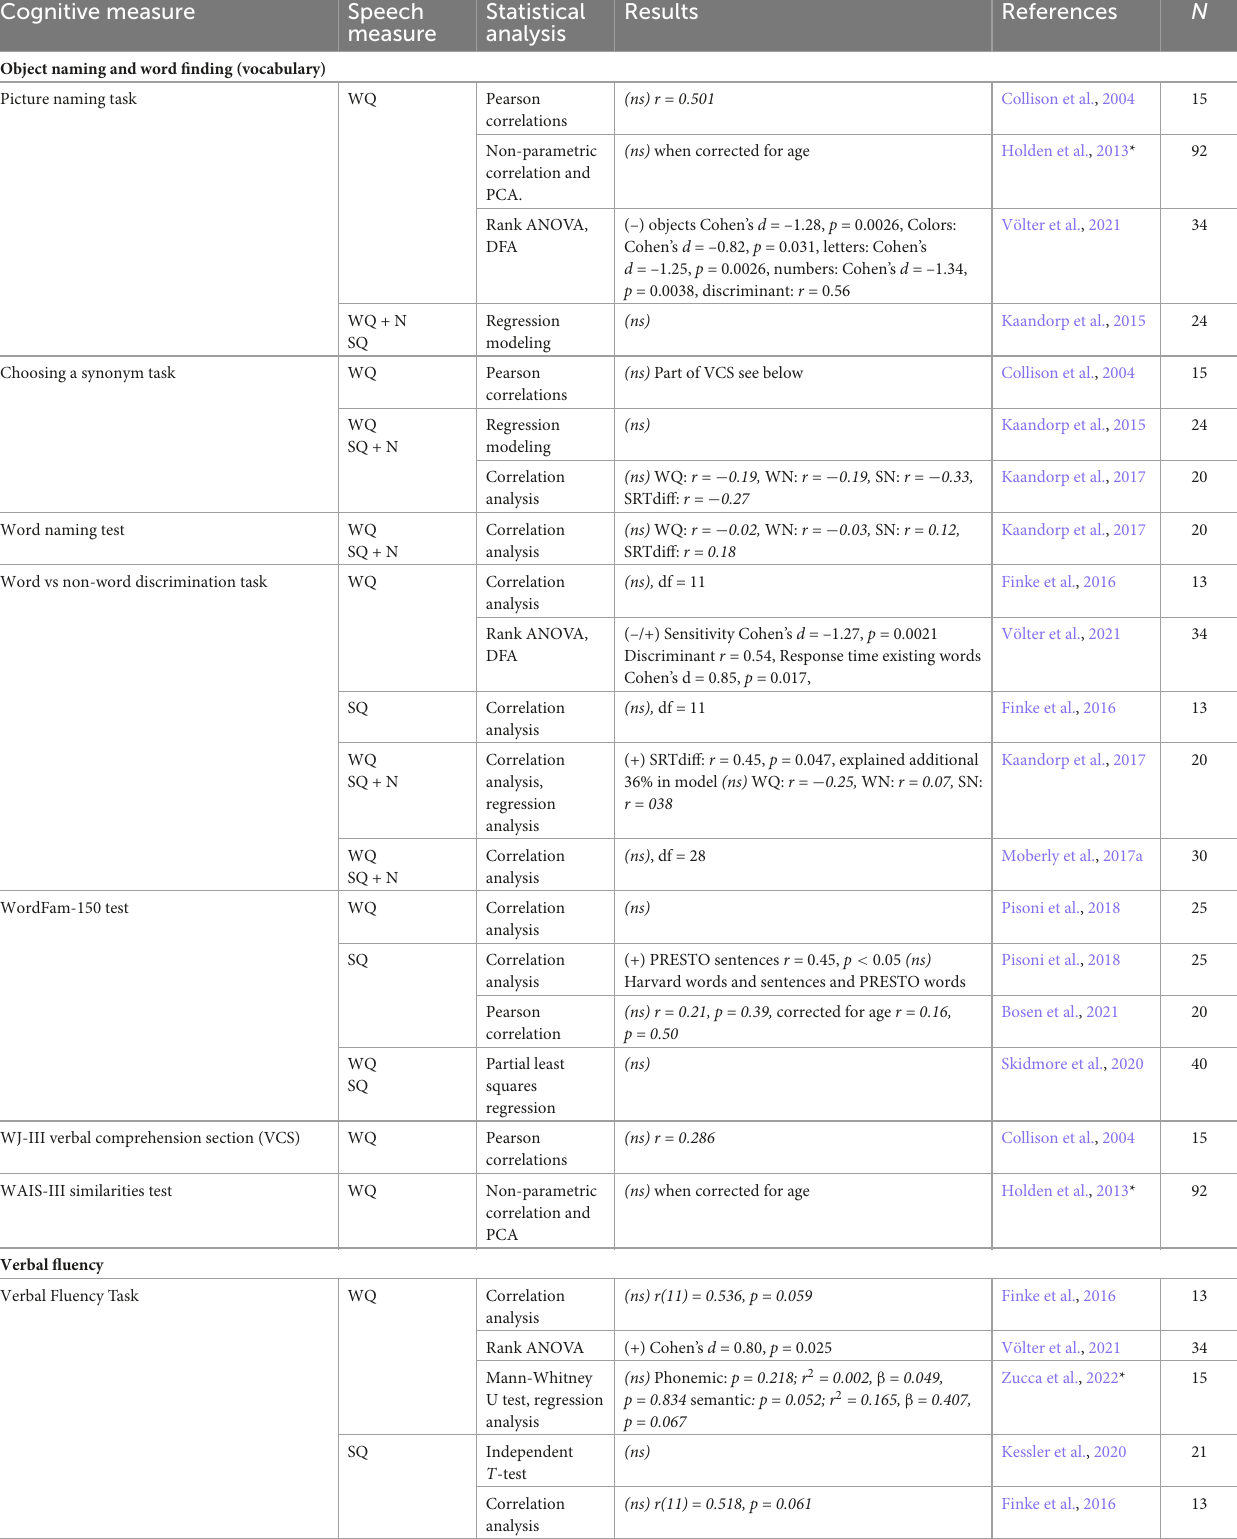
TABLE 11 Overview of included papers studying vocabulary and verbal